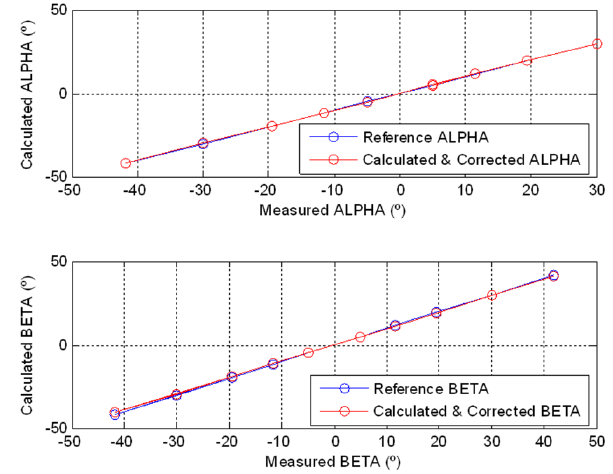
Figure 6. Corrected values of the tilt